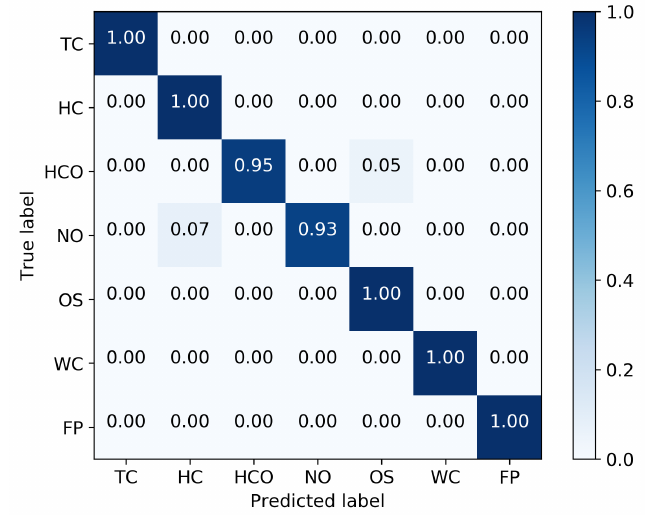
Figure 11. Confusion matrix for classification results on kitting experiment dataset with seven anomalies by HDP-HMM-AR-moVB method.